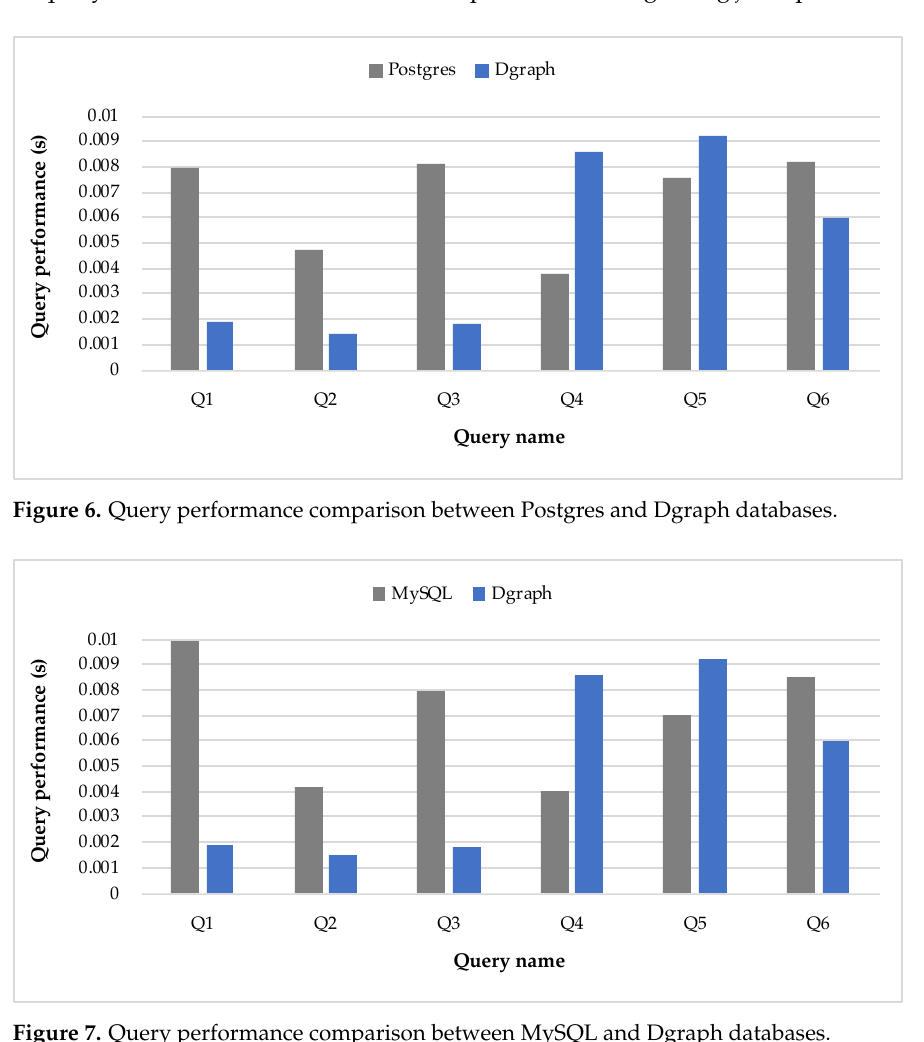
Figure 7. Query performance comparison between MySQL and Dgraph